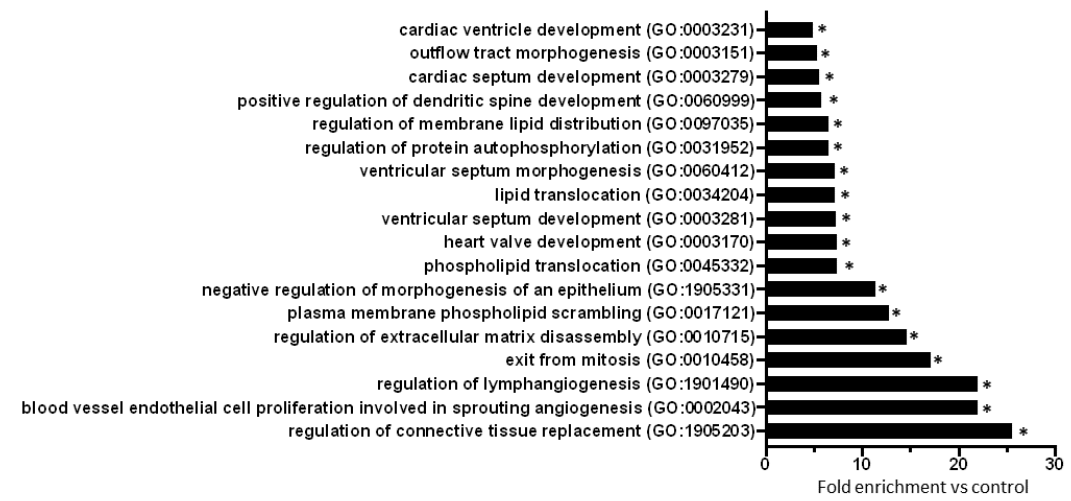
Figure 2. GO analysis (biological processes) of all miRNA target mRNAs ( n = 445) highlights the e ff ect of prediabetes on cardiac morphogenesis, development, lipid translocation, protein autophosphorylation, connective tissue replacement, extracellular matrix disassembly, and angiogenesis. Eighteen biological processes with the highest fold enrichment value are presented here. * p < 0.001, vs. Control (GO enrichment analysis with Bonferroni correction).